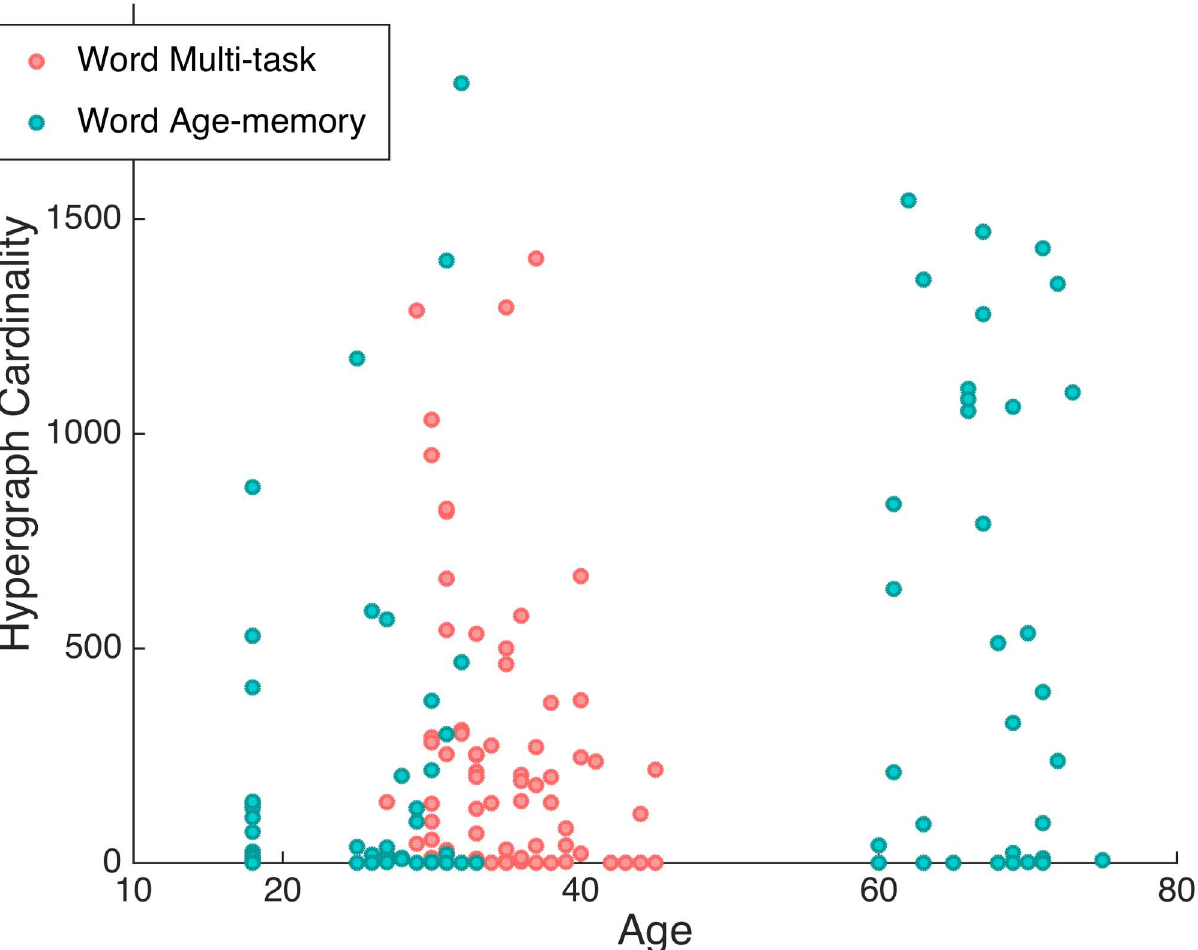
Fig 10. Hypergraph cardinality and age. Hypergraph cardinalityis shown as a function of age for the age-memory data set (blue) and word memory task of the multi-task data set (pink). Three distinct age groups are present for the age-memory data, while the multi-task ages overlap with the middleage-memorygroup. The correspondence between increasingage and larger hypergraph cardinalitycan be observed,where few older subjects have low hypergraph cardinalities, but the majority of the youngest subjects have cardinalities lower than